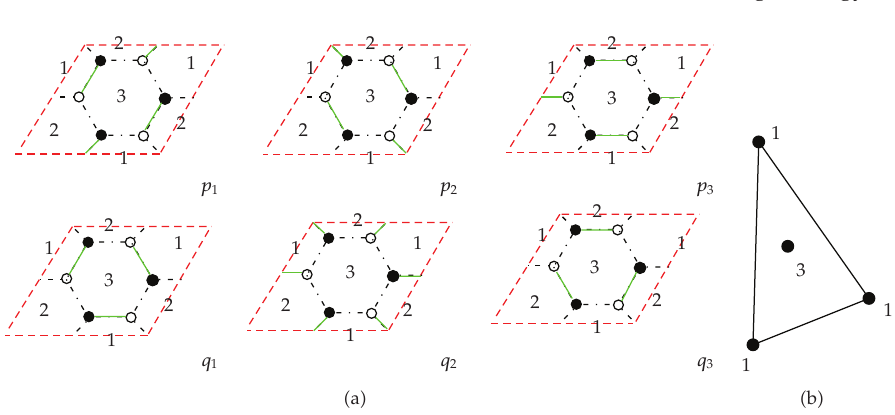
Figure 3: (cid:7) a (cid:8) The perfect matchings for the dimer model corresponding to dP 0 , with the external perfect matchings p i and the internal perfect matchings q i ; (cid:7) b (cid:8) The toric diagram of dP 0 with the labeled multiplicity of GLSM fields. The master space is given by the perfect matchings modulo relations (cid:4) 14 (cid:5) . There is one relation among perfect matching p 1 (cid:3) p 2 (cid:3) p 3 (cid:6) q 1 (cid:3) q 2 (cid:3) q 3 and this gives the description of the master space as C 6 / {− 1 , − 1 , − 1 , 1 , 1 , 1 } . We refer to (cid:4) 18, 19 (cid:5) for details on the Tiling construction and to